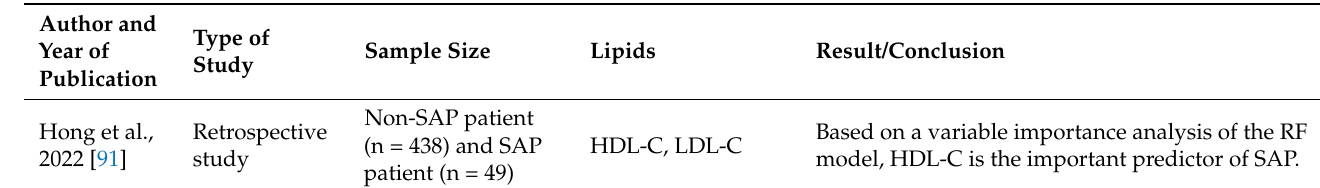
Table 3. Characteristics of included clinical studies related to relationship between HDL-C, Apo A1 and